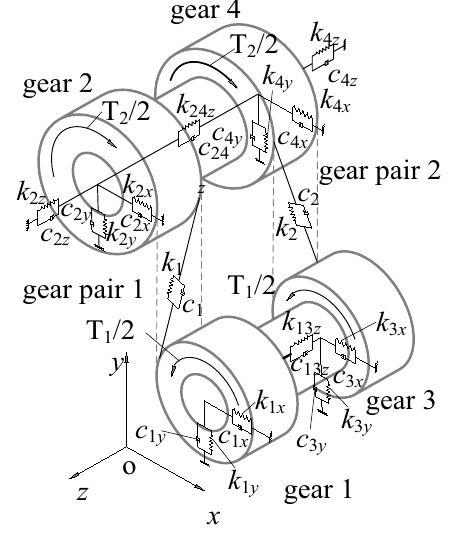
Fig. 1 Sixteen degrees of freedom coupling vibration model of her- ringbone